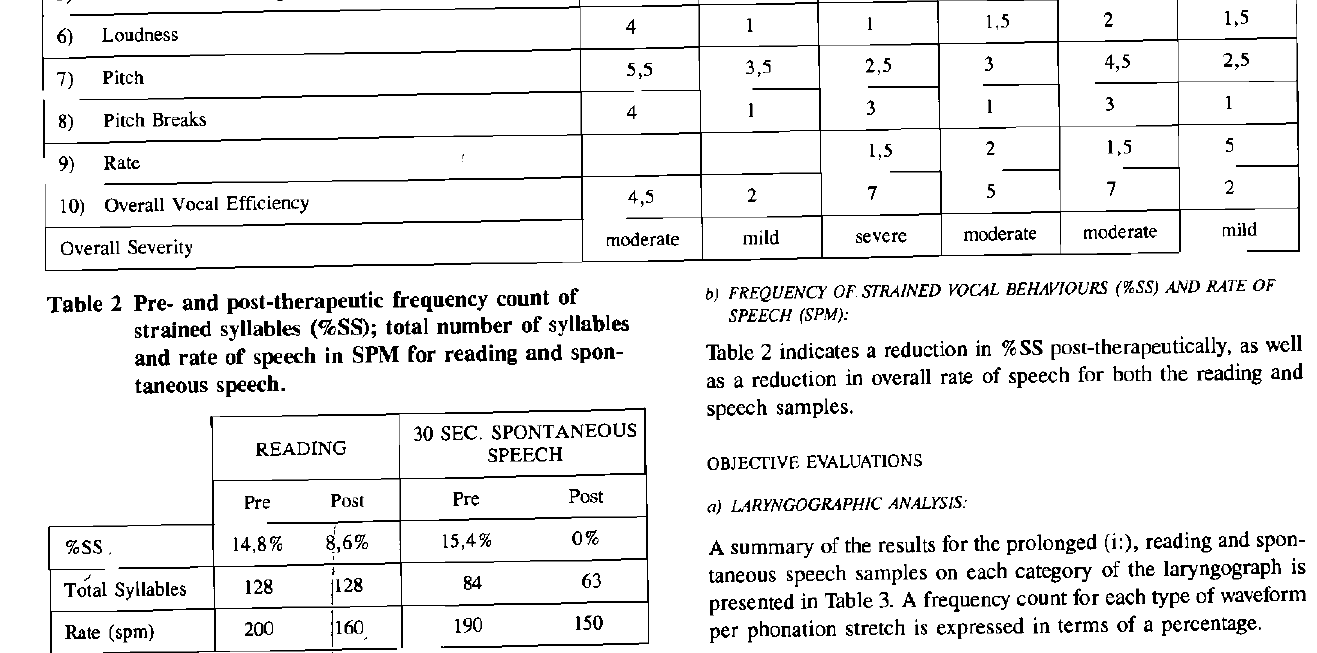
Table 3 Pre- and post laryligographic measures for prolonged /HI, reading and spontaneous speech, (n = total number 1